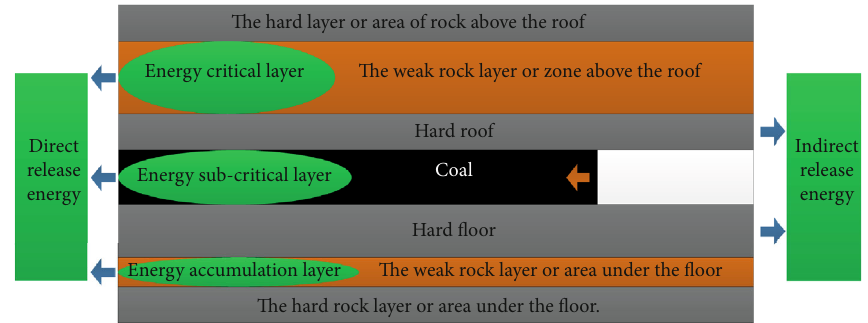
Figure 14: The schematic diagram of energy distribution in coal and rock